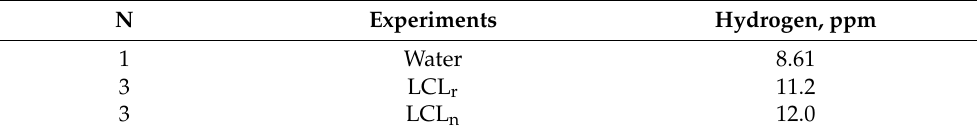
Table 6. Hydrogen concentration in the nitrogen steel after surface treatment in the environments. N